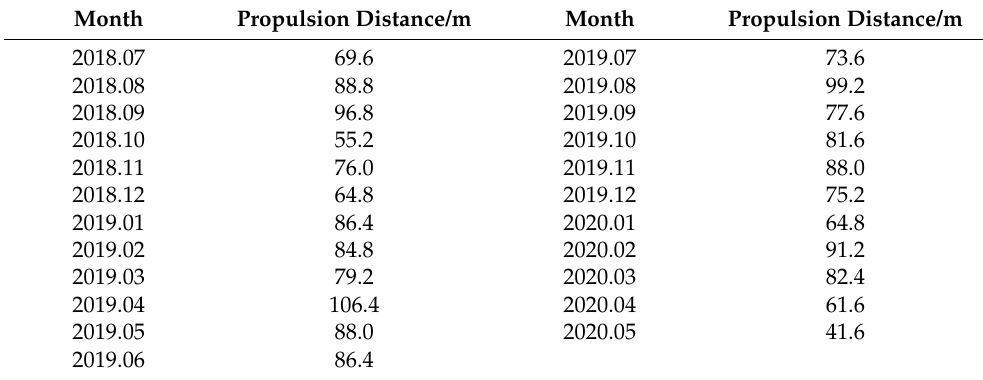
Table 2. The propulsion meter of the workface in each month.